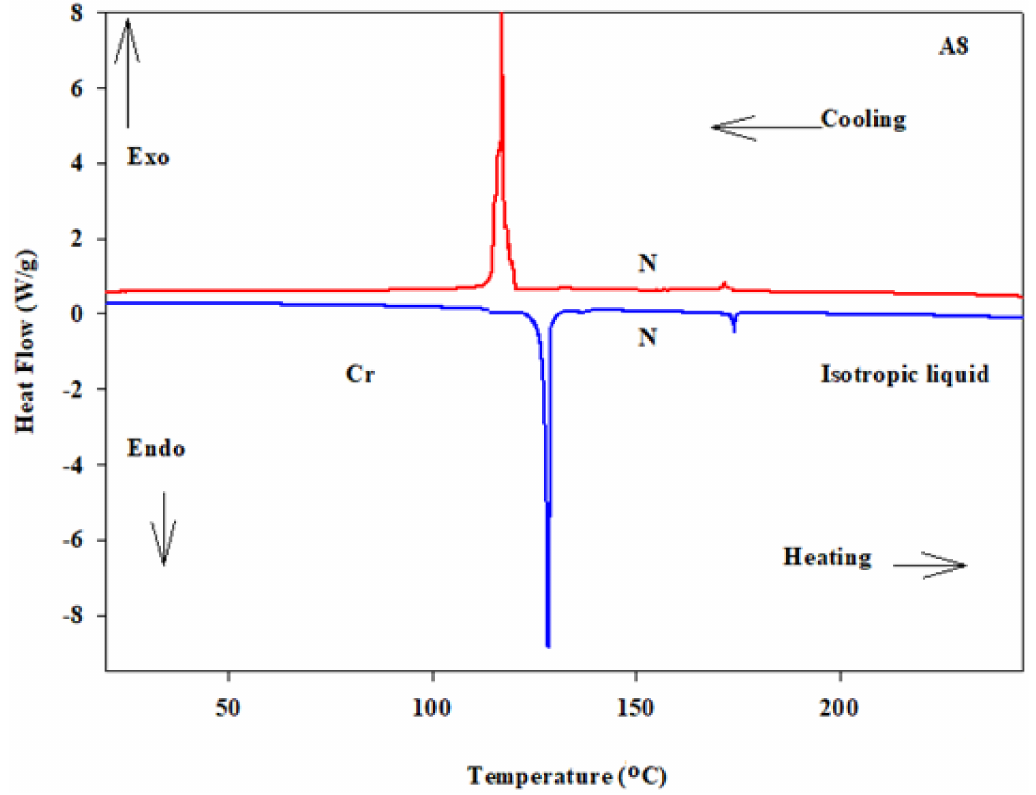
Figure 1. DSC thermograms of A8 derivative upon second heating-cooling scan with a rate of 10 ◦ C/min.